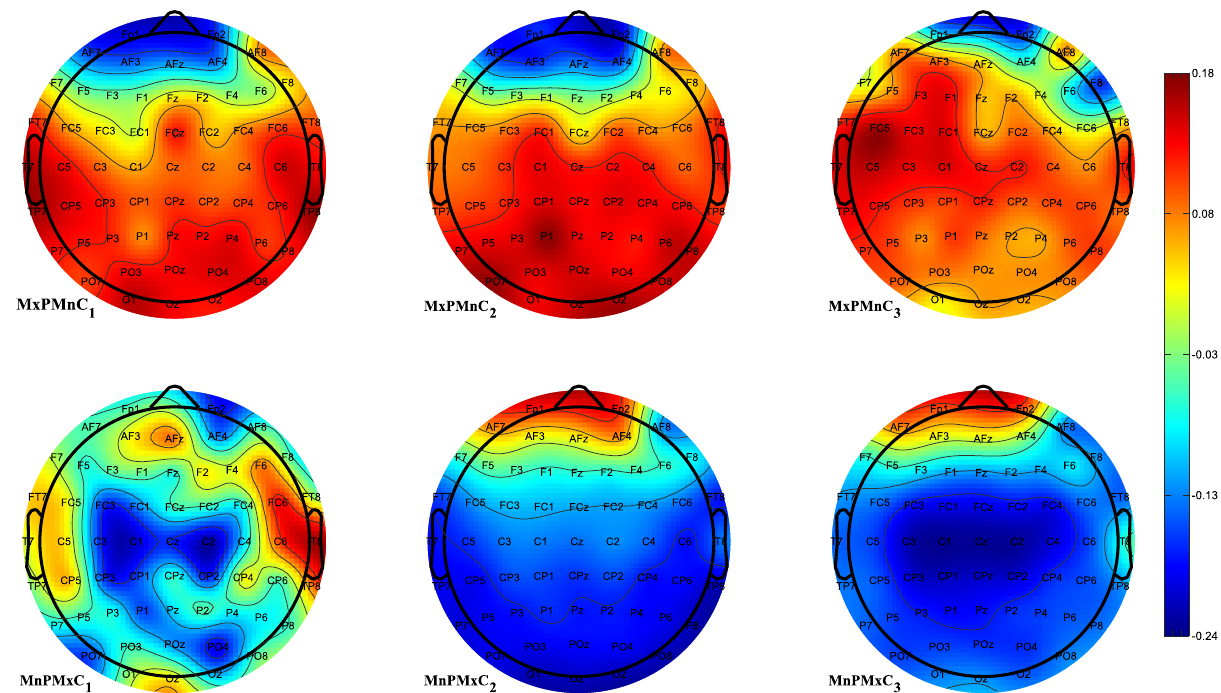
Figure 2. Topological plots of EEG channel contributions. In the top row are presented plots for the signals with maximized variance for the PD group and minimized variance for the control group (plots MxPMnC l , l = 1, 2, 3 ), while in the second row are plots for the signals with the minimized variance for the PD group and maximized variance for the control group (MnPMxC l , l = 1, 2, 3 ). For the calculation the interval of the length of 500 samples was used. Signals were band-pass filtered using the [0.1–20 Hz] filter. Figure was created using Matlab 2020b (https:// www. mathw orks. com/ produ cts/ matlab. html).